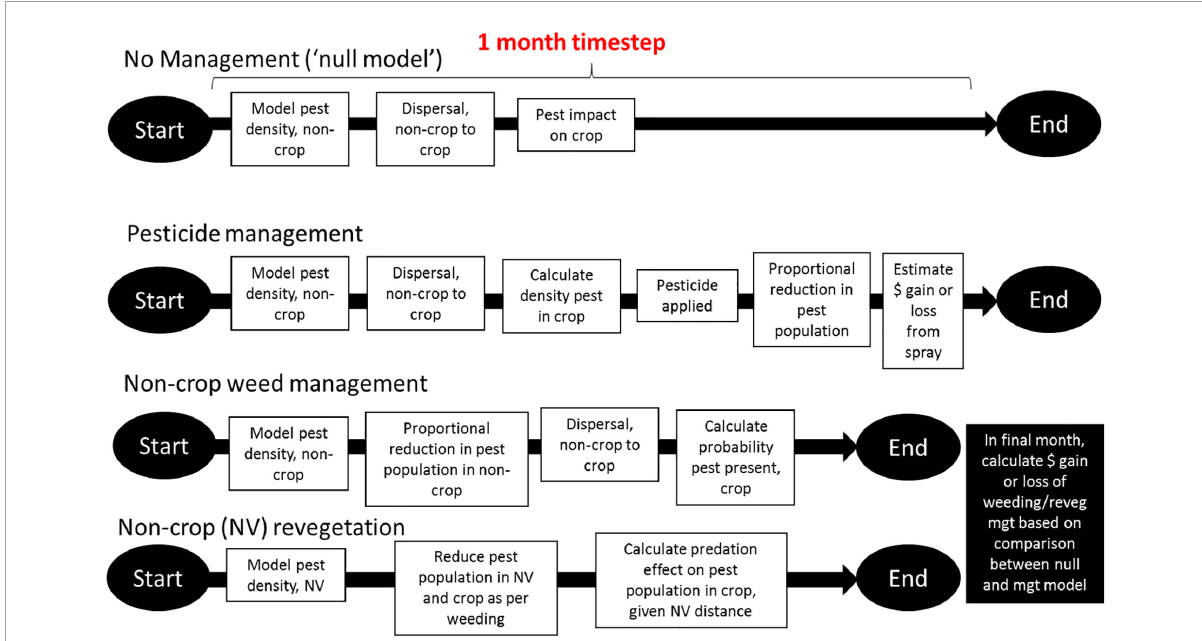
FIGURE2 Flow diagram showing, for each monthly timestep during the year, how non-crop weed management simulation processes and scheduling differ from pesticide management and no management. Revegetation management [remnant vegetation (NV) only] effects are calculated in a similar manner to non-crop weed